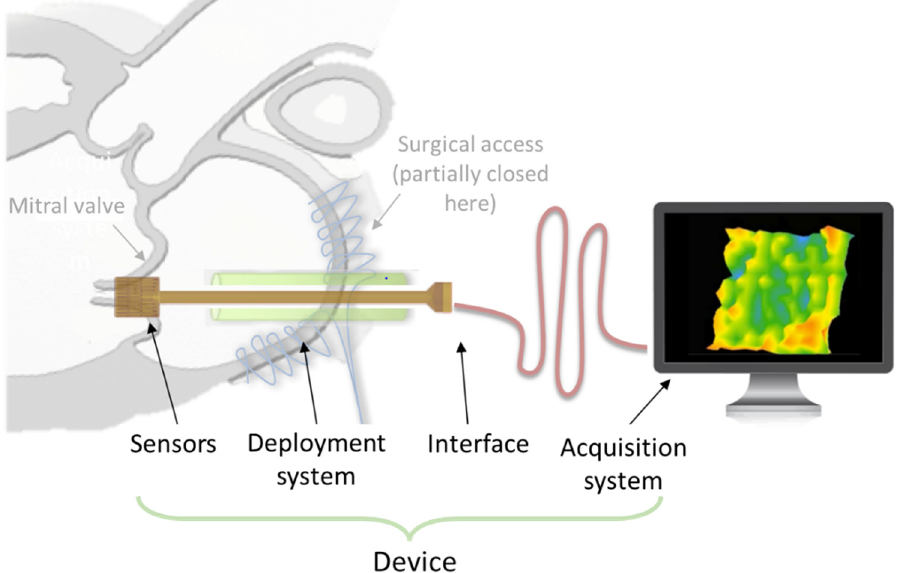
Figure 14. Working principle of the biosensor device used for force measurement of mitral valve